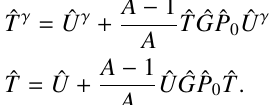
Figure 1. The real (right panel) and imaginary (left panel) parts of the M 3 / 2 plitude. The solid black curves correspond to the unmodified free-nucleon amplitude, and the dashed red curves represent the amplitude in the nuclear medium, modified by the e ff ective ∆ self-energy Σ = 11 . 3 − 27 . 5 i ∆